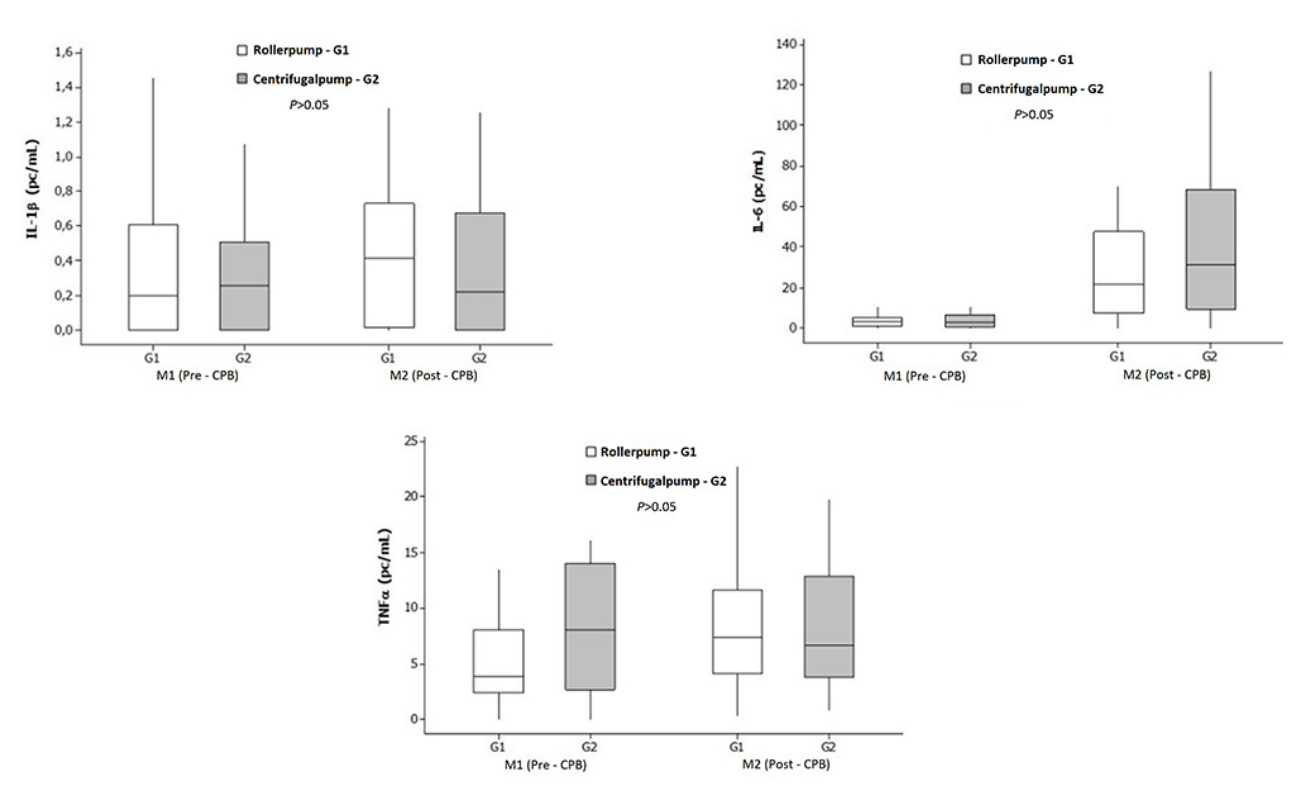
Fig. 3 – Median (range) IL-1β, IL-6, and TNF-α levels, stratified by group and time point. CPB=cardiopulmonary bypass; IL=interleukin The mortality rate at 48h PO was 10% in G1 (n=3; one death each due to stroke, pulmonary embolism, and cardiogenic shock) and 3.33% in G2 (n=1, due to ischemic stroke). Hence, 27 (90%) patients in G1 and 29 (96.67%) in G2 survived to discharge in the same